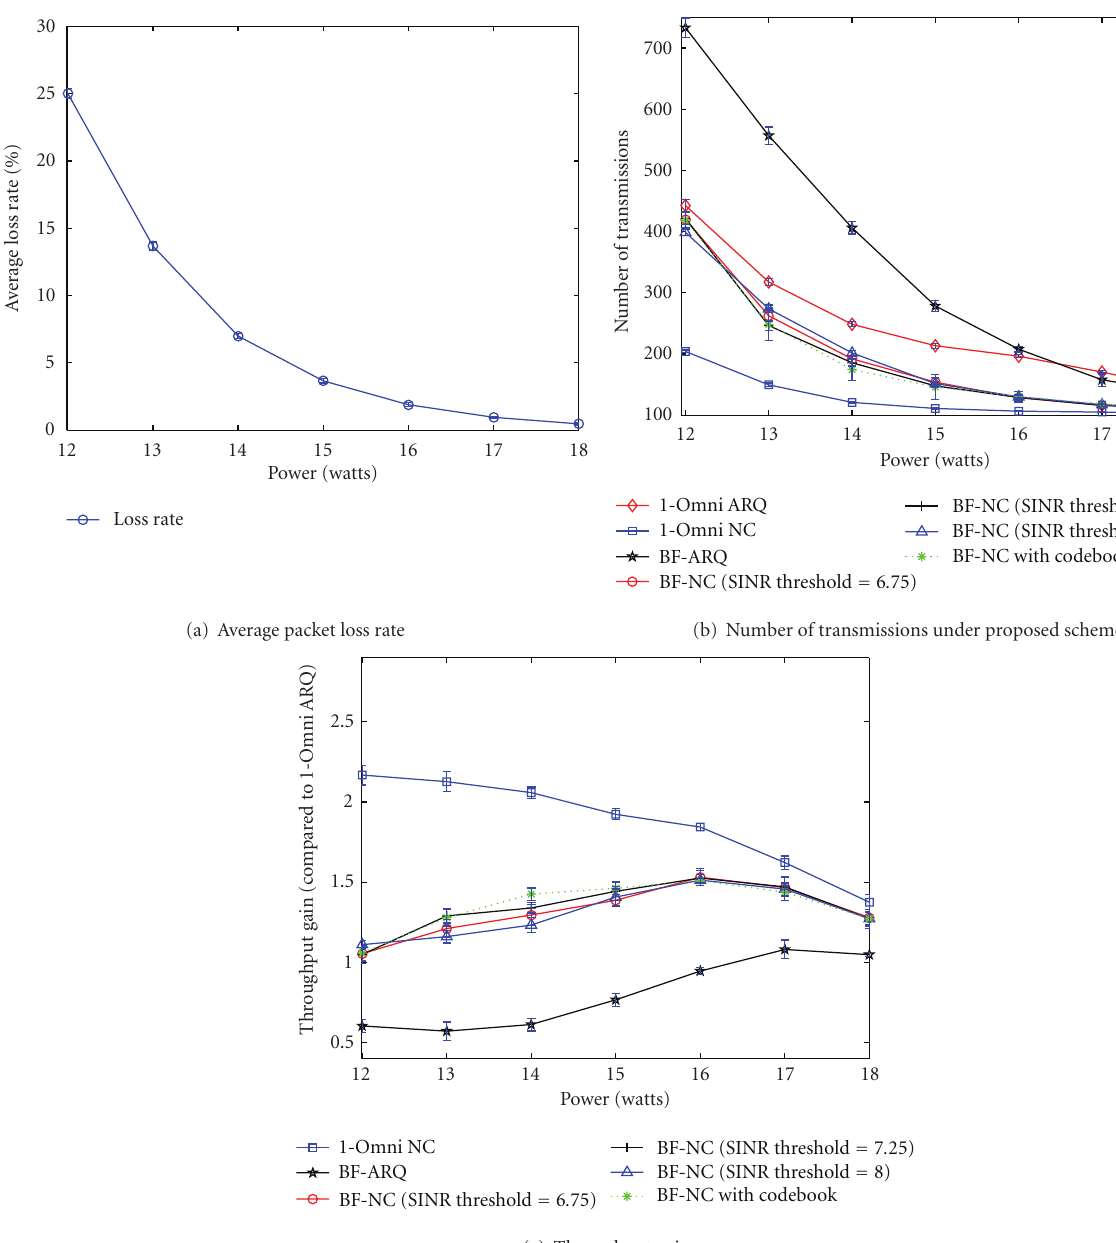
Figure 8: Simulation results for network topology scenario of Figure 7(a) with 120 uniformly distributed